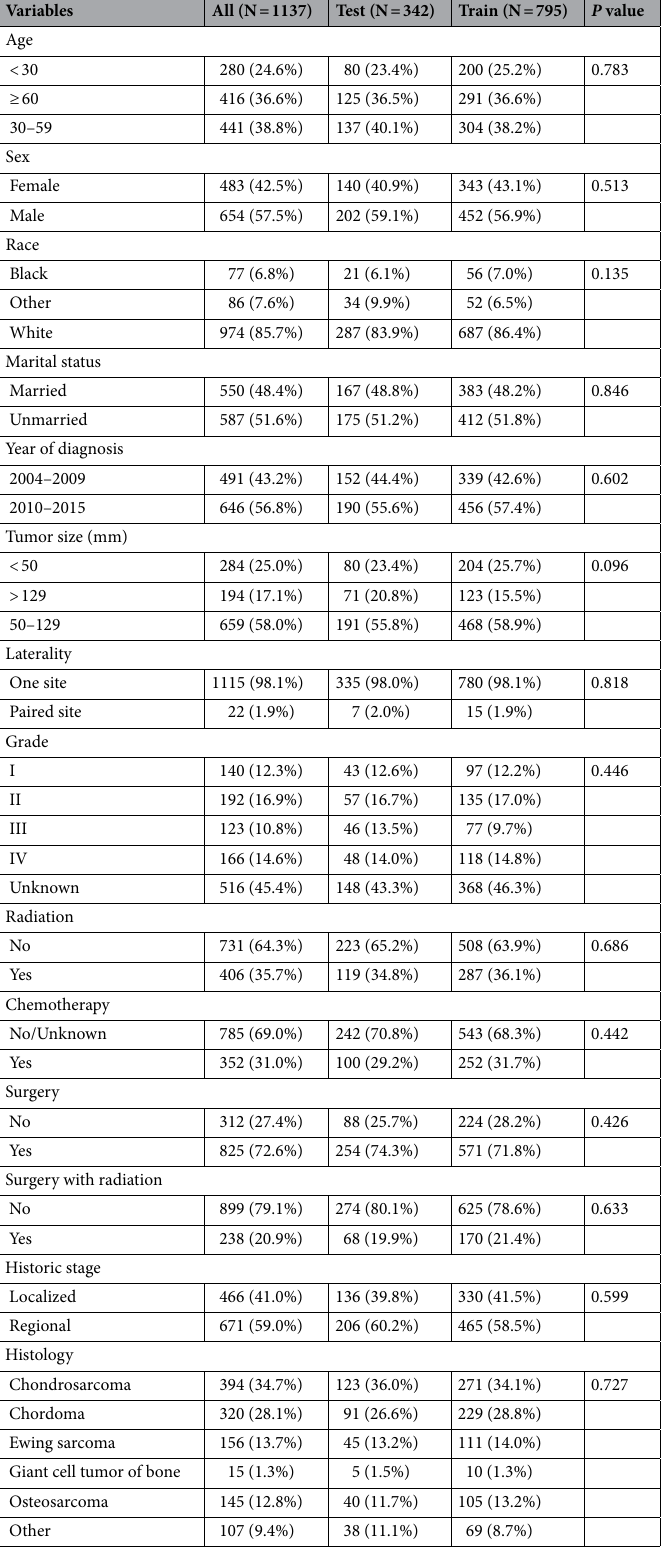
Table 1. Demographics and clinical characteristics of